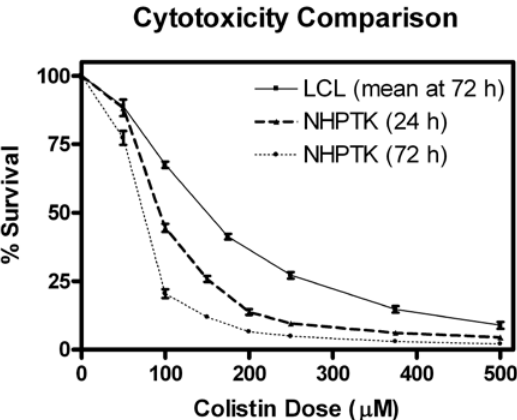
Figure 5. Cytotoxicity in LCLs and normal human proximal tubular kidney (NHPTK) cells. A mean of all 68 cytotoxicity curves is provided for the LCLs 72 h after colistin exposure. Normal human proximal tubular kidney cells were more sensitive to colistin than LCLs at 72 h. Normal human proximal tubular kidney cells exposed to colistin had relatively greater survival at 24 h as compared to 72